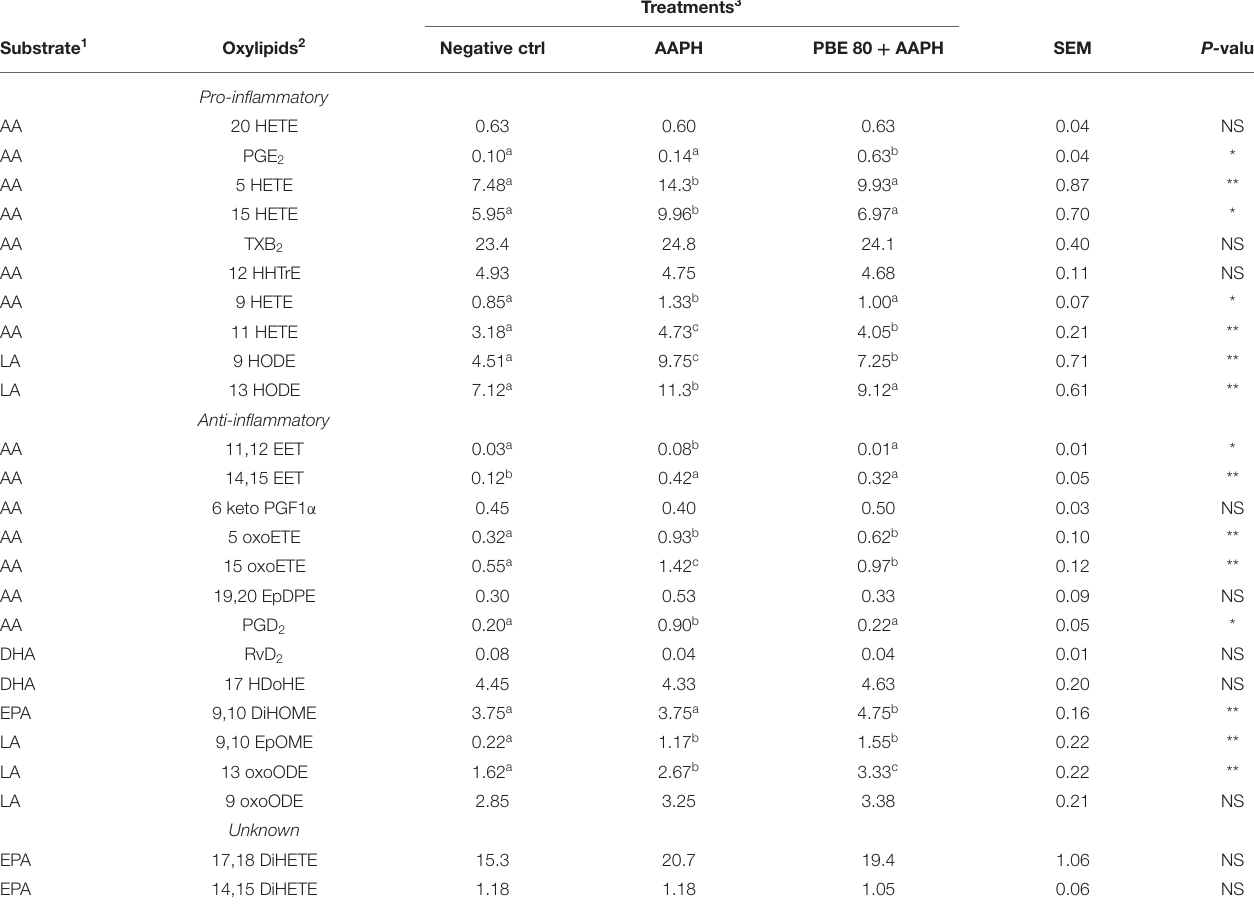
TABLE 2 | Concentration of oxylipids (nM) in bovine aortic endothelial cells pre-treated with pomegranate by-product extract 80 µ g/ml after 6h of 5mM AAPH exposure. Treatments